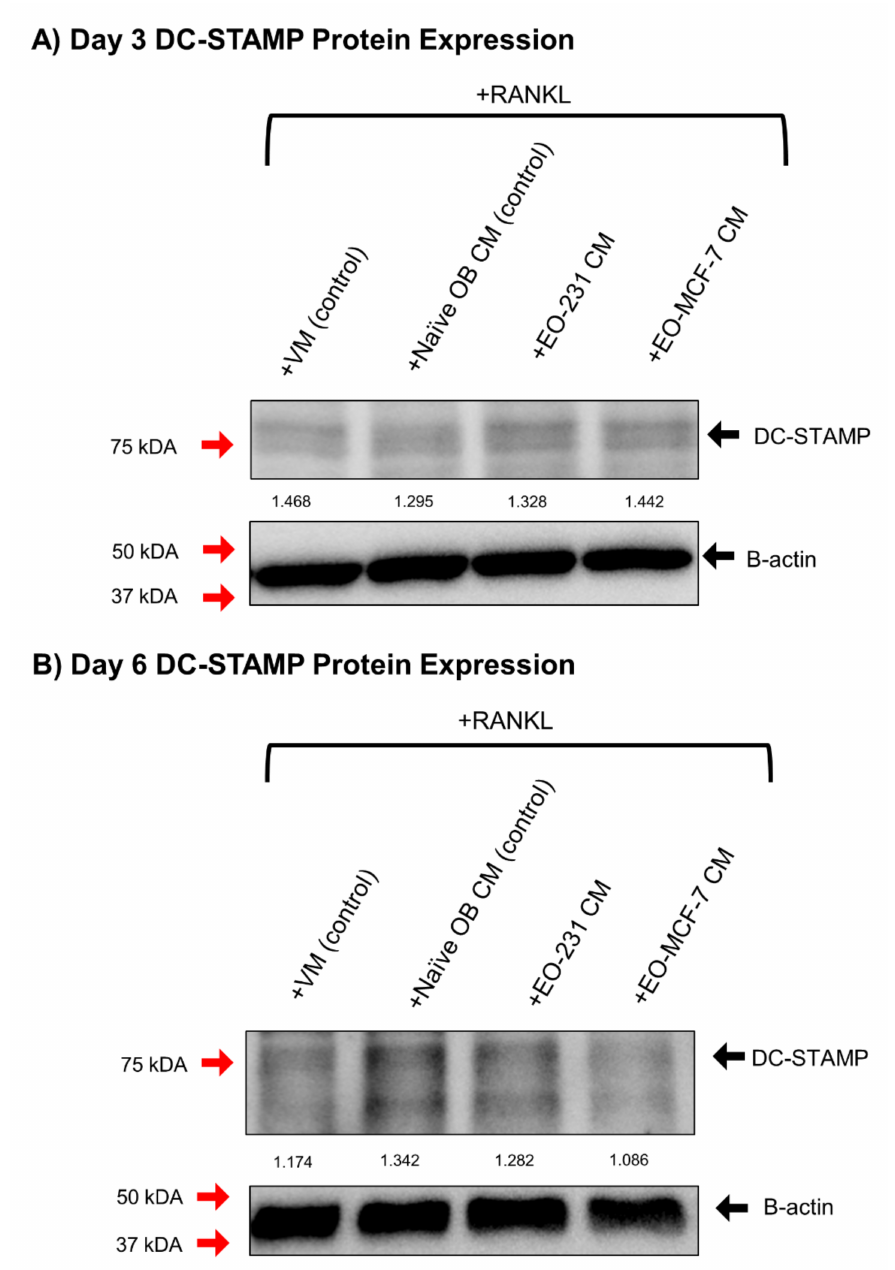
Figure 6. DC-STAMP Expression is Reduced in Pre-Osteoclasts Exposed to EO CM. RAW 264.7 pre- osteoclasts were exposed to naïve OB CM (control), EO-231 CM, or EO-MCF-7 CM in the presence of 50 ng/mL exogenous RANKL for ( A ) three days, or ( B ) six days. RAW 264.7 pre-osteoclasts maintained in vehicle media (VM) in the presence of 50 ng/mL exogenous RANKL for ( A ) three days, or ( B ) six days served as additional controls. Uncropped Western Blots are available in Figures S6 and S7. Cell lysates were collected and subjected to western blot for the osteoclast fusion factor, dendrocyte expressed seven transmembrane protein (DC-STAMP; black arrow). The red arrow indicates 75 kDa, 50 kDa, and 37 kDa, respectively. β -actin (black arrow) served as a loading control. Values shown are band densitometry measurements for DC-STAMP protein expression, which was normalized to β -actin protein expression. For day 3, DC-STAMP protein expression densitometry values, as normalized to β -actin protein expression, were 1.468 (+VM; control), 1.295 (+Naïve OB CM; control), 1.328 (+EO-231 CM), and 1.442 (+EO-MCF-7 CM). For day 6, DC-STAMP protein expression densitometry values, as normalized to β -actin protein expression, were 1.174 (+VM; control), 1.342 (+Naïve OB CM; control), 1.282 (+EO-231 CM), and 1.086 (+EO-MCF-7